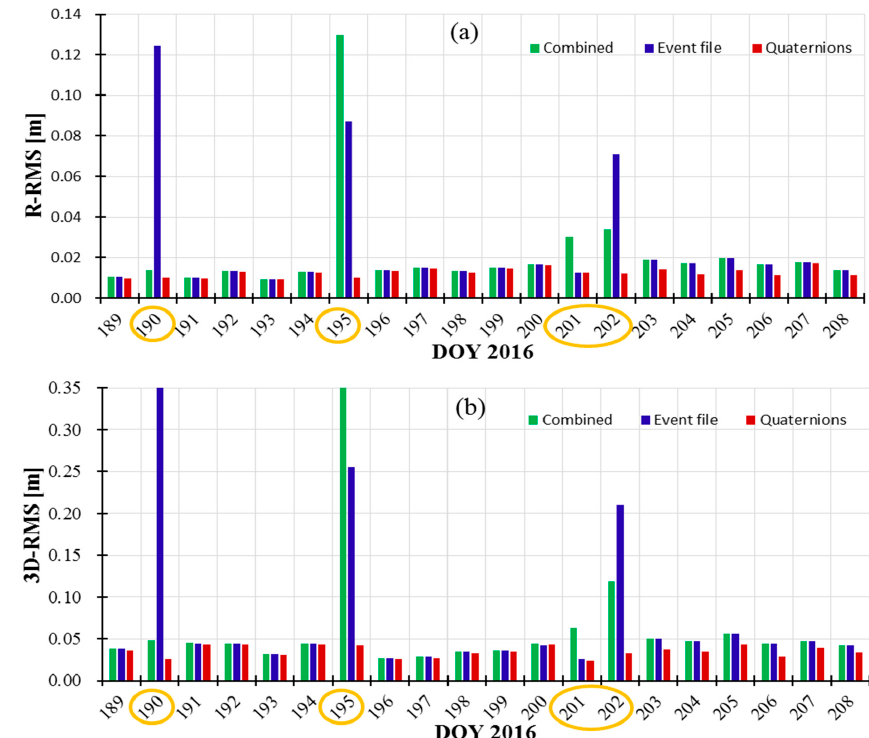
Figure 8. Comparison of orbital accuracies (RMS) on R direction ( a ) and 3D position ( b ) based on different attitude modes (using combined attitude in green, using event file in blue and using quaternions in red).